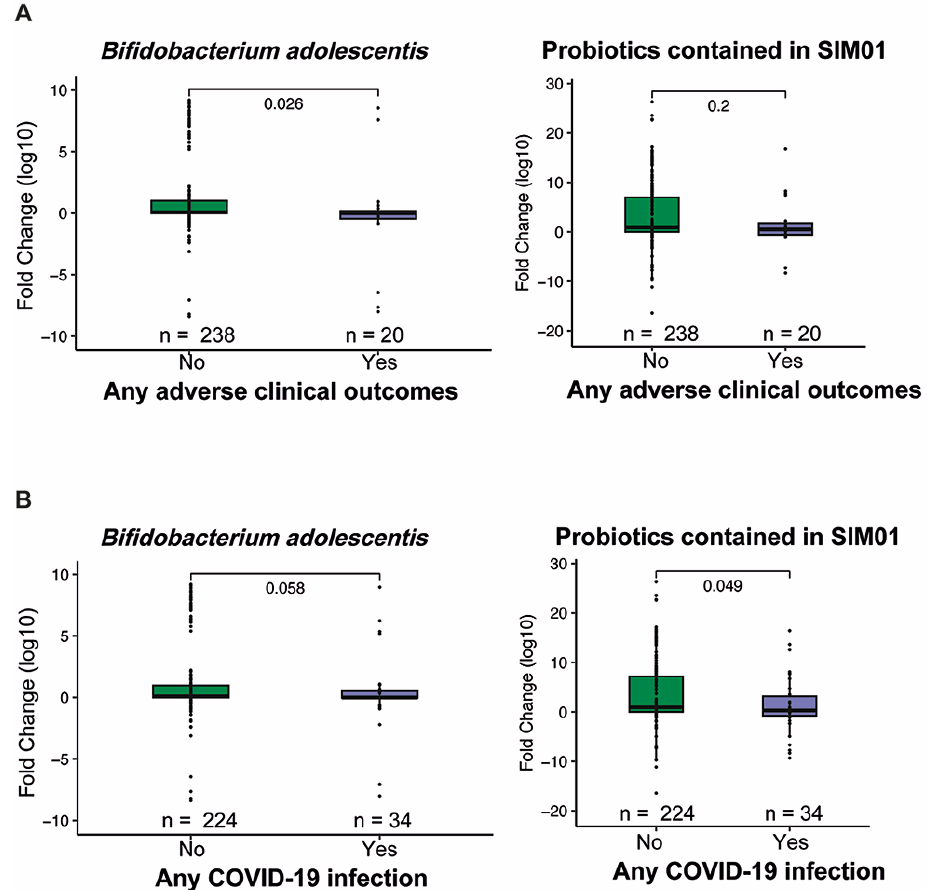
Figure 3. ( A ) The fold change (month 3/baseline) of B. adolescentis was lower in subjects with any adverse health outcomes. ( B ) The fold change (month 3/baseline) of B. adolescentis and the fold change (month 3/baseline) of three probiotic species in SIM01 were lower in subjects with COVID-19 infection. The p values were given by the Wilcoxon rank-sum test (two-sided). Elements on boxplots: centre line, median; box limits, upper and lower quartiles; points, each sample.